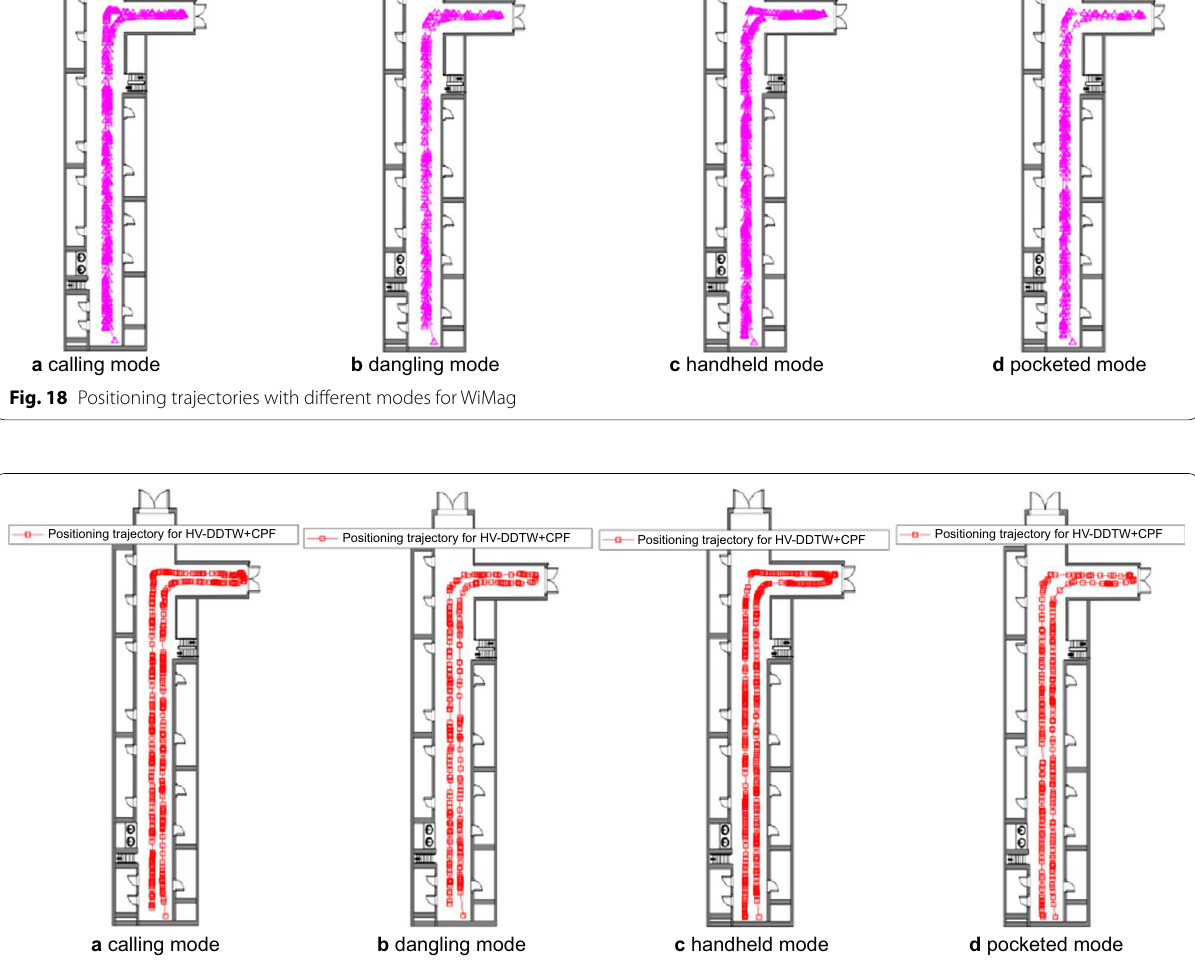
Fig. 19 Positioning trajectories with different modes for HV-DDTW